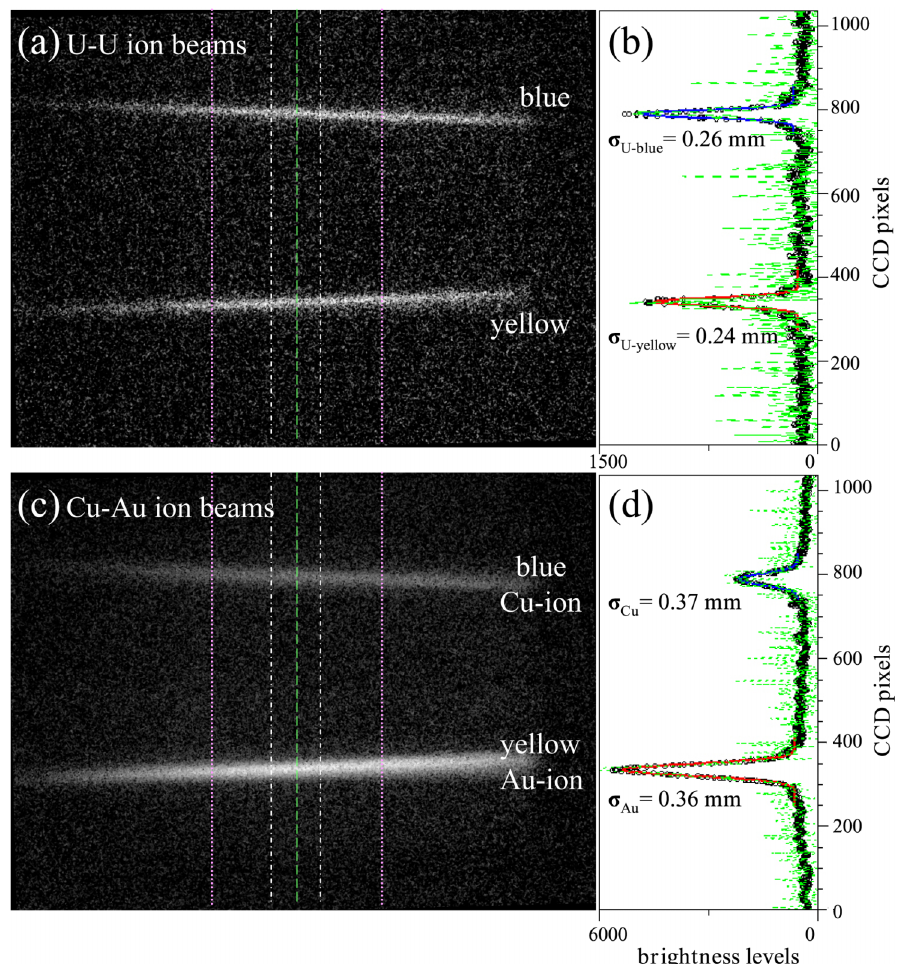
FIG. 2. (a) Fluorescence profiles of RHIC 96 : 4 GeV = n U-U ion beams, no spectral filtering, 60 seconds exposure time. The field of view is 36.5 by 27.3 mm ( 1388 (cid:1) 1038 CCD pixels), the image area between the dotted magenta lines depicts the depth-of-focus region of the imaging system. (b) Green dashed line: Y-projection at the center of the U-U profile; black open circle: average of 100 Y-projections within the dot-dashed lines region of the image; red and blue solid lines are their respective Gaussian fit for the Yellow and Blue beams. (c) (d) Same as (a) and (b) but for 100 GeV = n Cu-Au ion beams instead. Fitted ion beam width (cid:6) values of 9.14, 9.97, 13.8, and 14.1 pixels, with (cid:7) 2 > 0 : 96 confidence level, are obtained for U-Yellow, U-Blue, Au, and Cu beams, respectively; while their beam-beam separations are (cid:3) 47 (cid:6) and (cid:3) 33 (cid:6) for U-U and Cu-Au